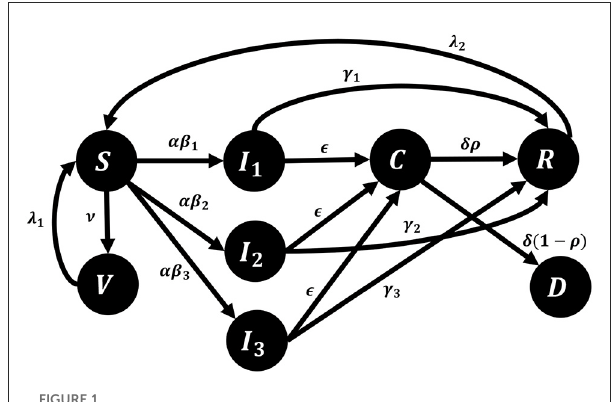
FIGURE1 Model dynamics of COVID-19 with three strains.